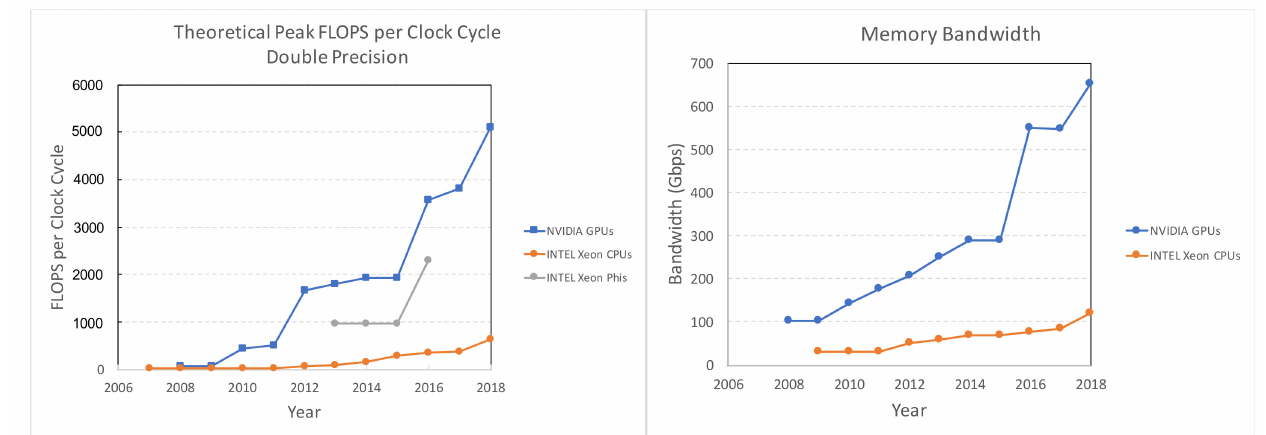
Figure 1. Computational benchmarks for NVIDIA GPU vs. Intel CPU hardware platforms. The left panel illustrates theoretical floating-point operations (FLOPS) per clock cycle and the panel on the right illustrates theoretical memory bandwidth in gigabits per second